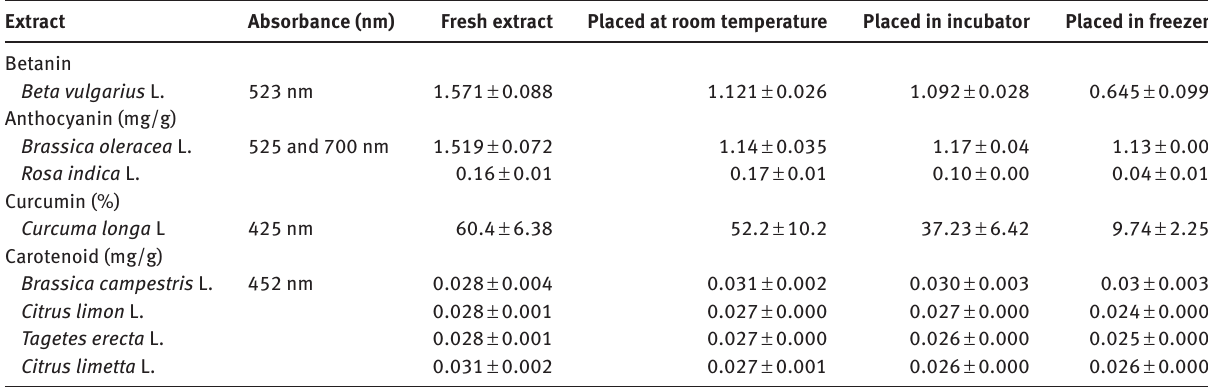
Table 3: Spectrophotometric analysis of different color compounds.